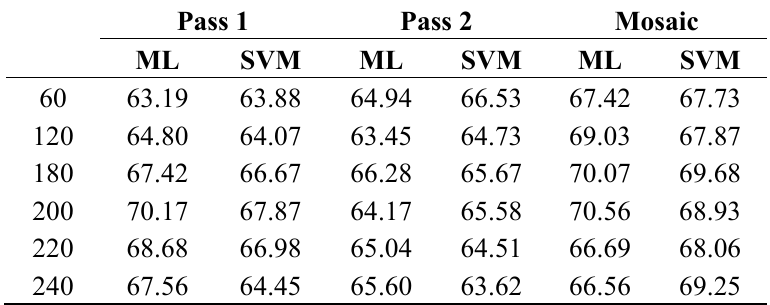
Table 3. Analysis of the resolution between images and classifiers based on overall accuracy.